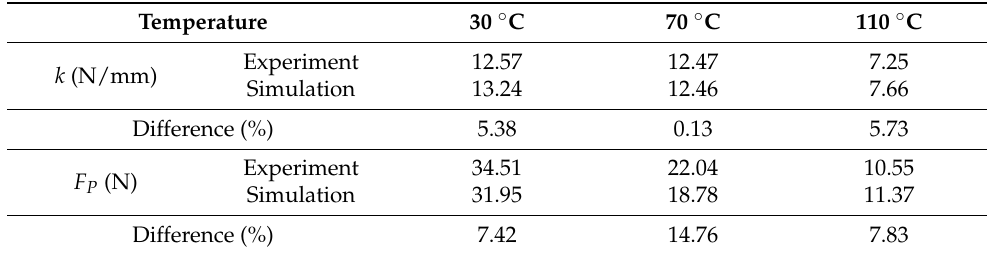
Table 5. Mode-I slope and peak load data comparison between experimental and simulation